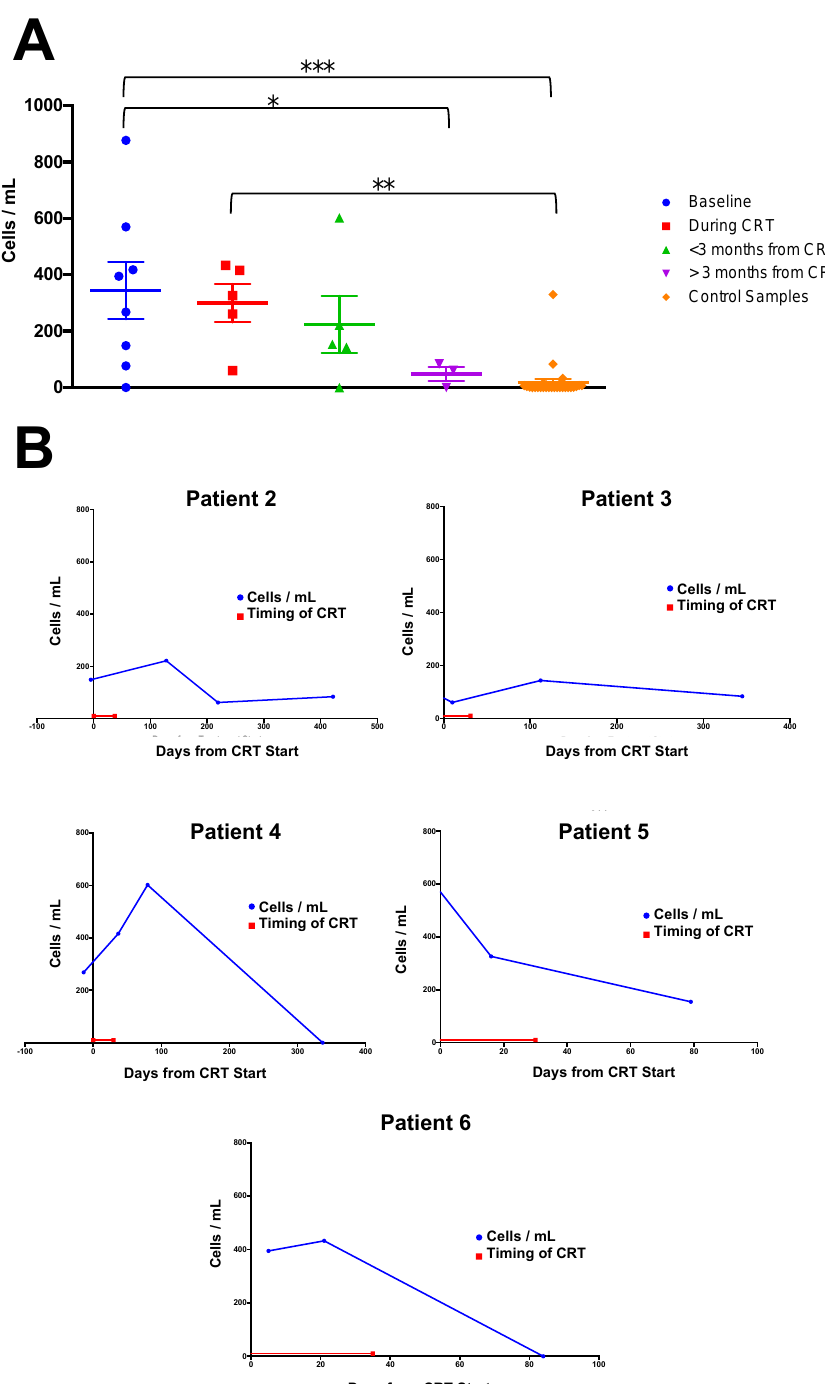
Figure 2. ( A ) CC counts were divided into baseline samples, those taken during CRT (and up to one week after EOT), those taken within 3 months of EOT and those taken over 3 months from EOT. Control samples were obtained from 28 volunteers. When analysed using a one-way analysis of variance (ANOVA), a significant difference was observed between baseline levels and control samples ( p < 0.001), baseline samples and those taken >3 m from treatment ( p < 0.05) and between samples taken during treatment and controls samples ( p < 0.01). ( B ) Individual profiles of CC count (cells/mL) over time in the five patients for whom there were 3 or more samples available. Treatment timing is shown is red, whilst blue lines represent CC counts.